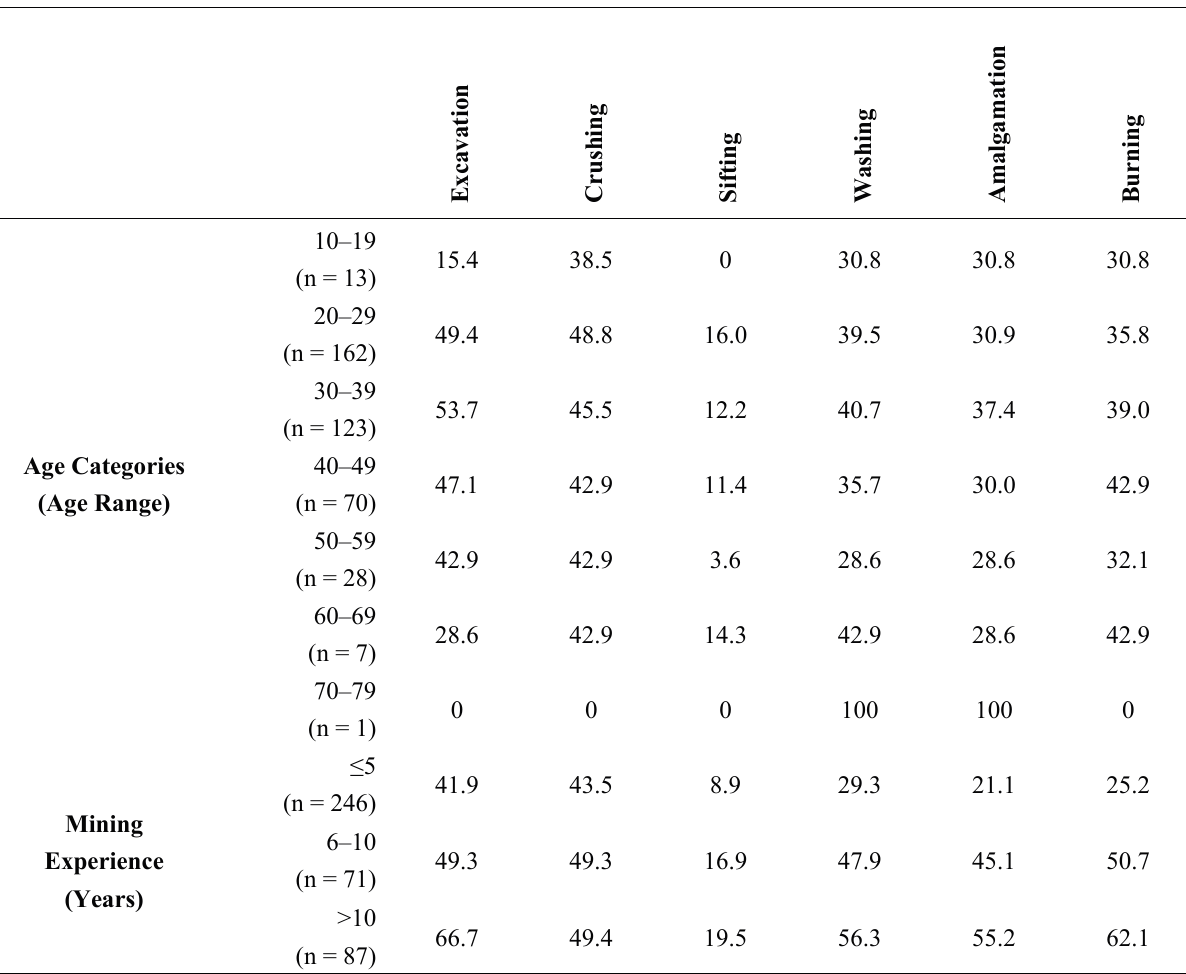
Table 2. Percentage of miners participating in the key artisanal and small-scale gold mining activities in the Tarkwa (Ghana) study sites according to age and duration of mining. Note, rows do not add up to 100%, since many miners are regularly involved in more than one activity.